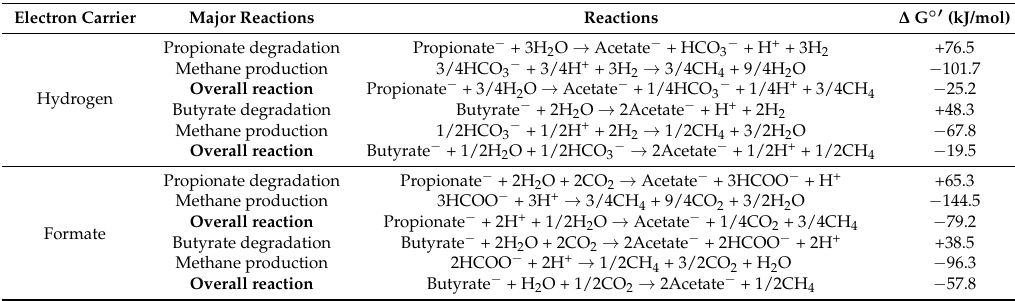
Table 1. Major reactions of syntrophic metabolisms via interspecies hydrogen/formate transfer and their Gibbs free energy ( ∆ G ◦(cid:48) ) at pH